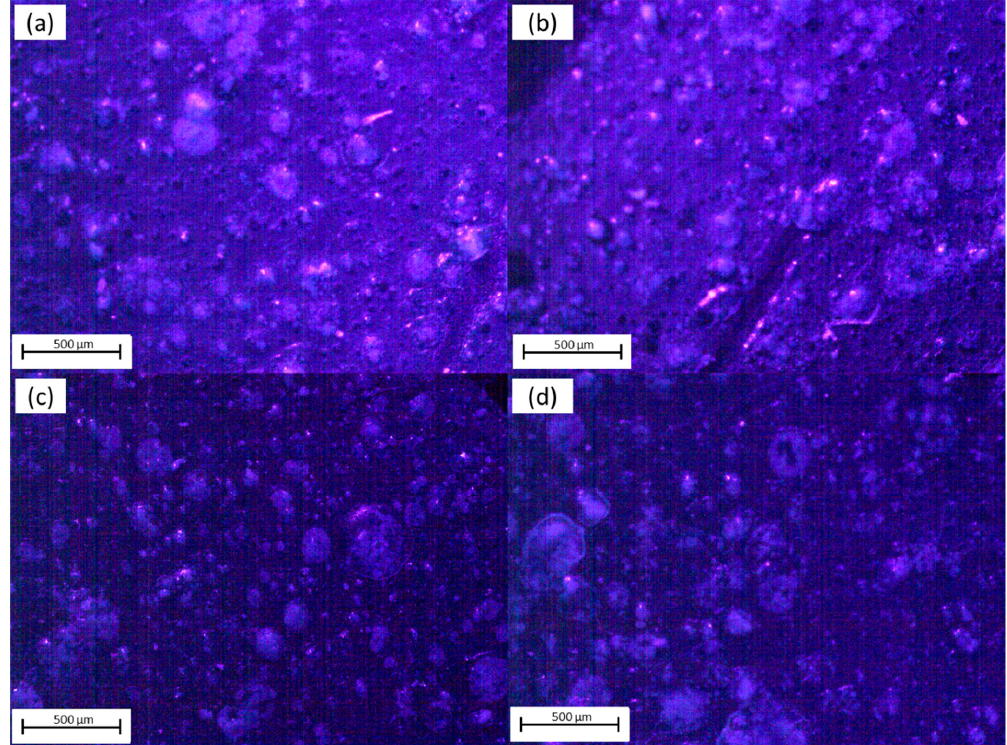
Figure 4. OFET optical characterization under UV light conditions. ( a ) Region 1; ( b ) Region 2; ( c ) Region 3; ( d ) Region 4. Table 1. Fluorescent density (%) for the di ff erent OFET